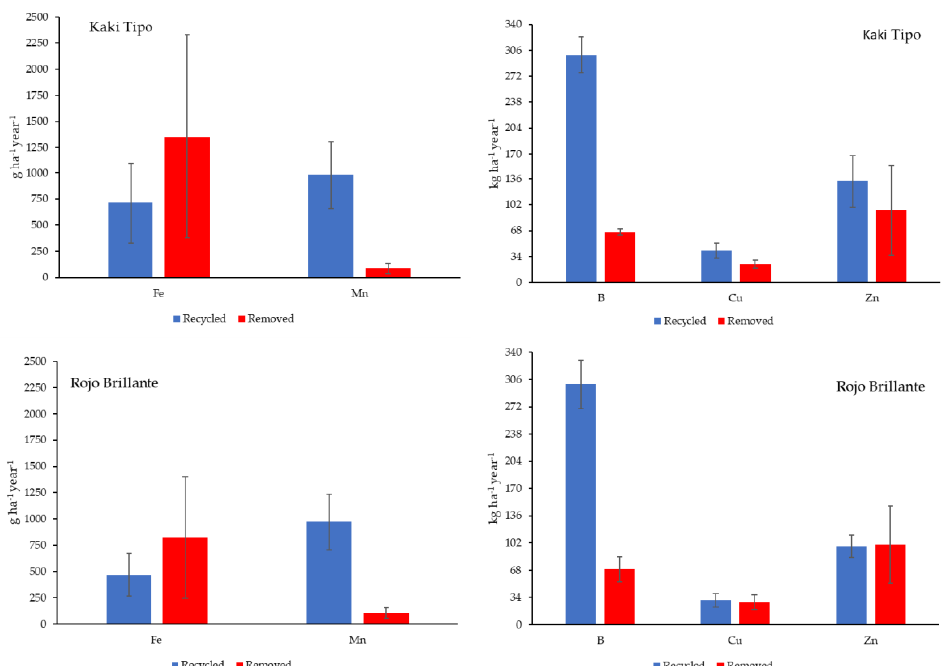
Figure 6. Amounts of micronutrients recycled and removed in mature persimmon orchard. Recy- cled nutrients: abscised leaves + pruned wood; removed nutrients: fruits + roots and skeleton. Means ± SD ( n = 20 for leaves, fruits and pruned wood, and 4 for skeleton and roots). For micronutrients the average orchard yearly demand was 368 g B ha −1 , 79 g Cu ha −1 , Table 6. Total annual demand of micronutrients (g ha −1 year −1 ) of mature persimmon orchard. Total Demand B Cu Fe Mn Kaki